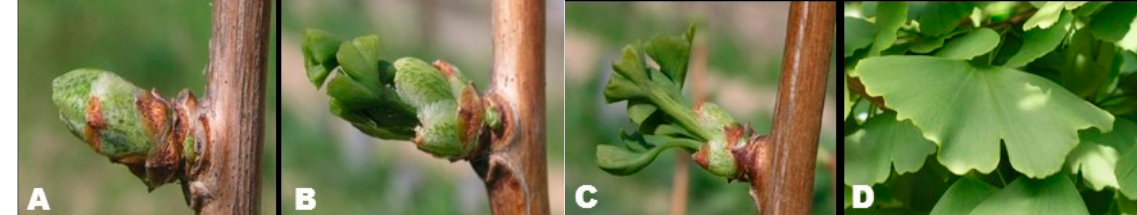
Figure 1. G. biloba, from buds to leaves; ( A ) closed buds; ( B ) semi-opened buds; ( C ) opened buds; ( D ) summer leaves.